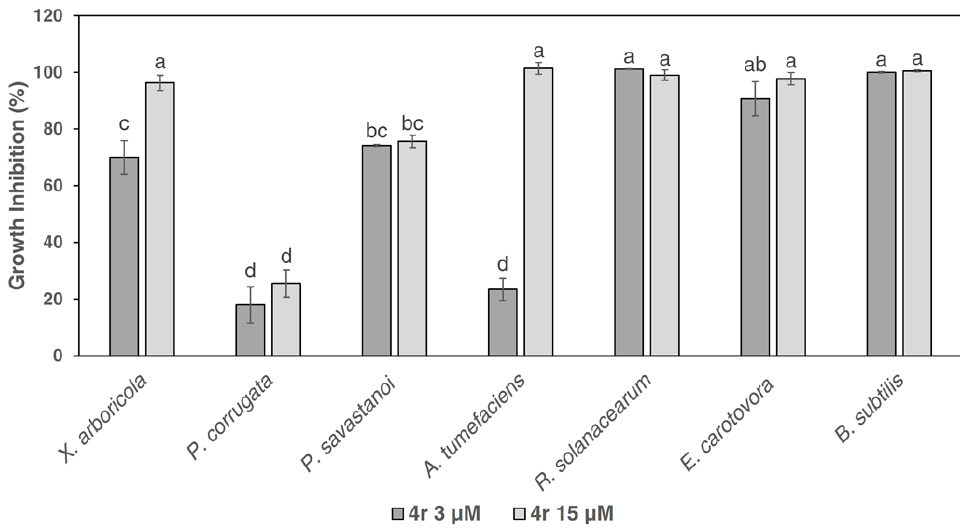
Figure 2. Efficacy of the C-terminal-modified peptide 4r, tested at 15 µ M and 3 µ M, in inhibiting the in vitro growth of the Gram-negative bacteria Xanthomonas arboricola , Pseudomonas corrugata , Pseudomonas savastanoi pv. savastanoi , Agrobacterium tumefaciens , Ralstonia solanacearum , and Erwinia carotovora subsp. carotovora , as well as the Gram-positive bacterium Bacillus subtilis. Bars indicate standard errors. Three replicates were performed for each bacterial peptide concentration. Two independent experiments were performed. Data were statistically analyzed by a one-way ANOVA followed by the Tukey–Kramer Post Hoc Test. Different letters indicate significant differences at p < 0.05.